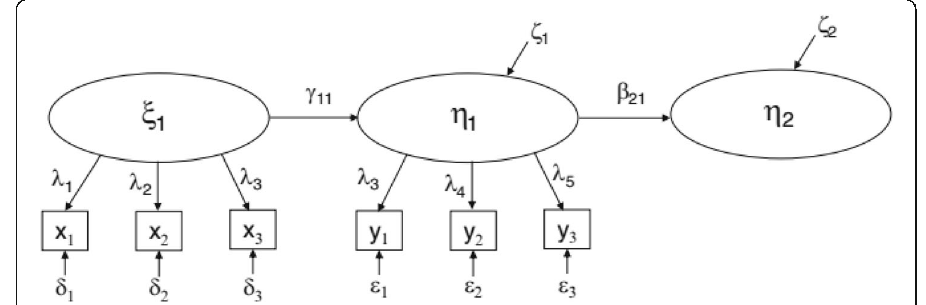
Fig. 1 Example of SEM model. Source: Catherine et al.